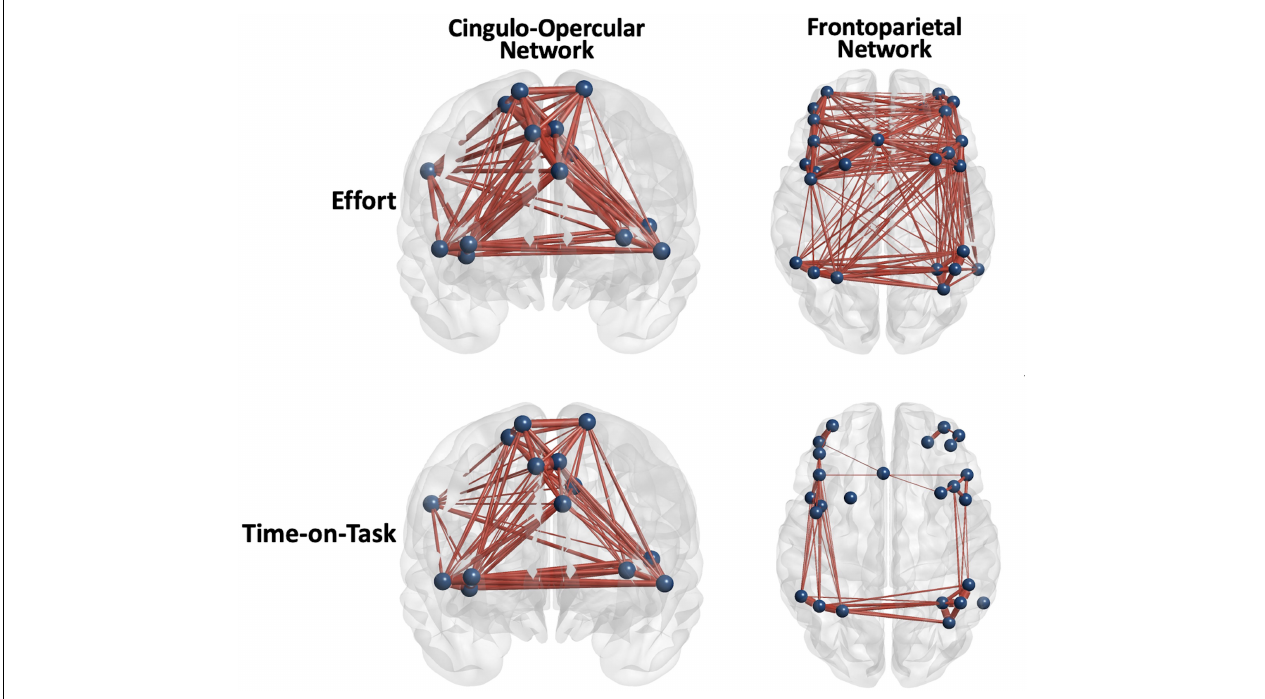
FIGURE 3 | Positive main effects of effort level and time on task (TOT) for all the participants combined were robust, but the FP network was more diffusely engaged in effort level task manipulation. Edge thickness = t -value for the edge in the